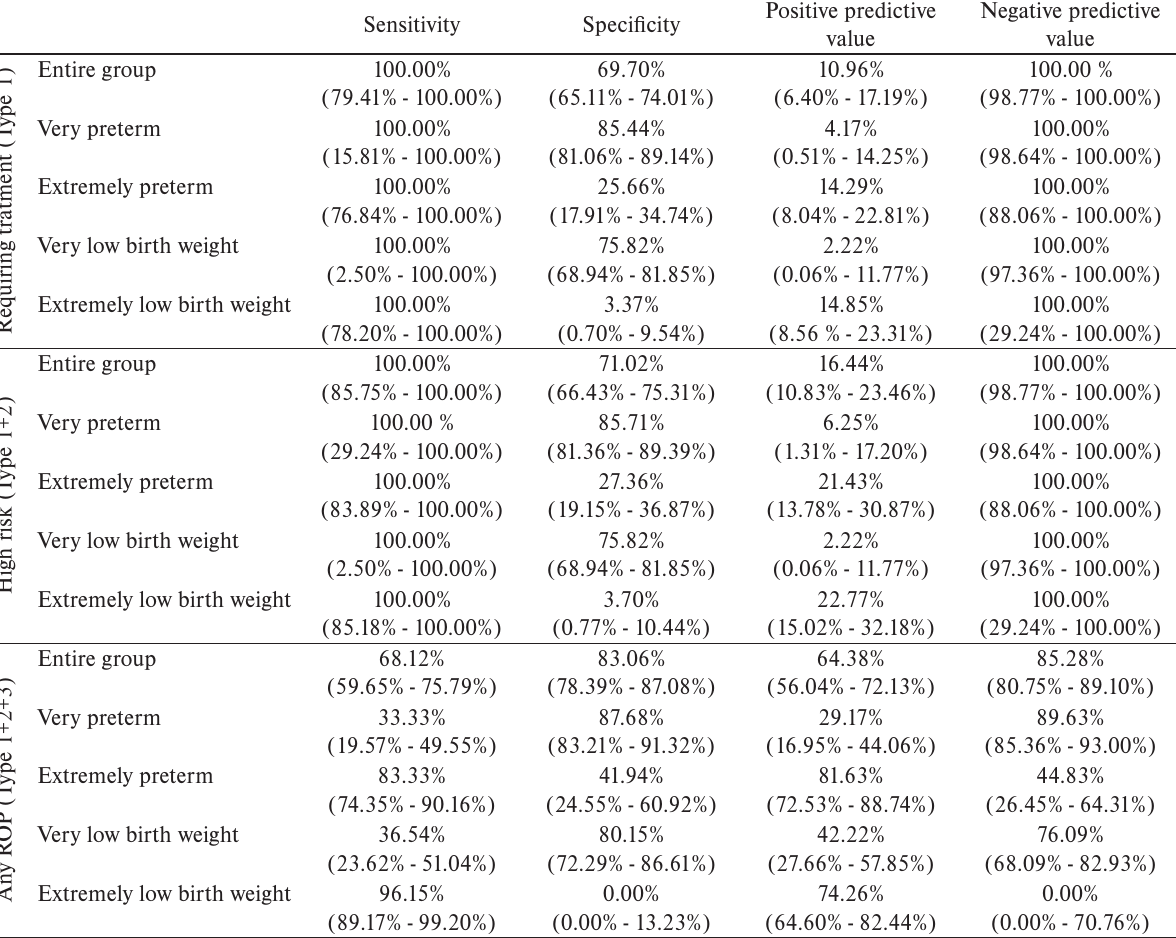
Table 2. WinROP test characteristics including 95% Clopper-Pearson confidence